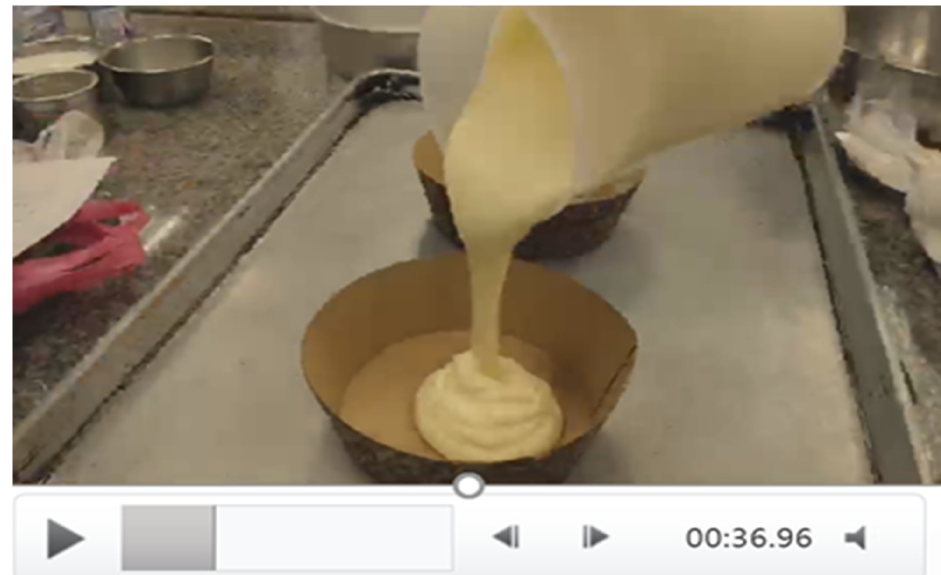
Figure 2. Videos for making dessert products.